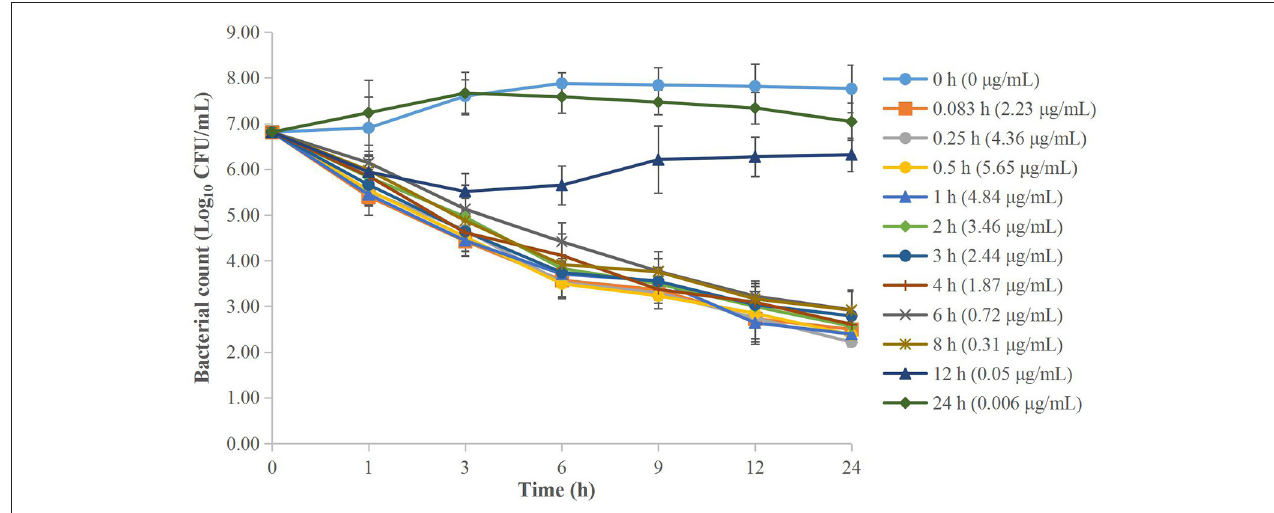
FIGURE 4 | Ex vivo time-kill curves of cefquinome against A. pleuropneumoniae in serum before and after intramuscular administration. Values are the mean ± standard deviation ( n = 6).